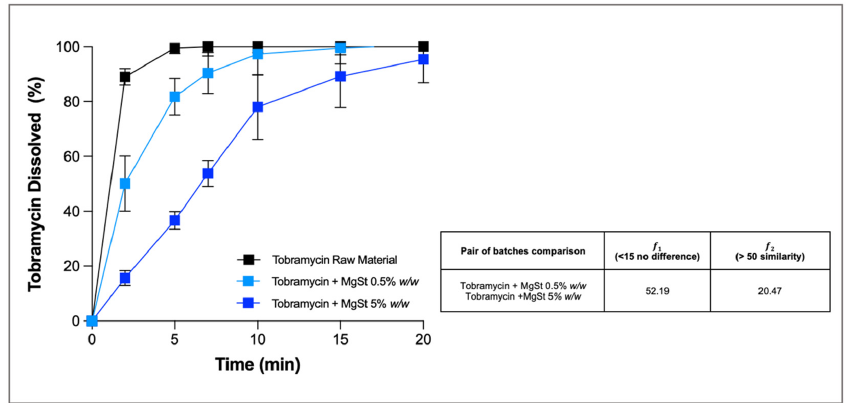
Figure 2. Cumulative mass (%) dissolution profiles of tobramycin bulk inhalation powders containing increasing amounts of magnesium stearate (0% w / w black, 0.5 w / w light blue and 5% w / w blue symbols) ( n = 3, mean ± SD).